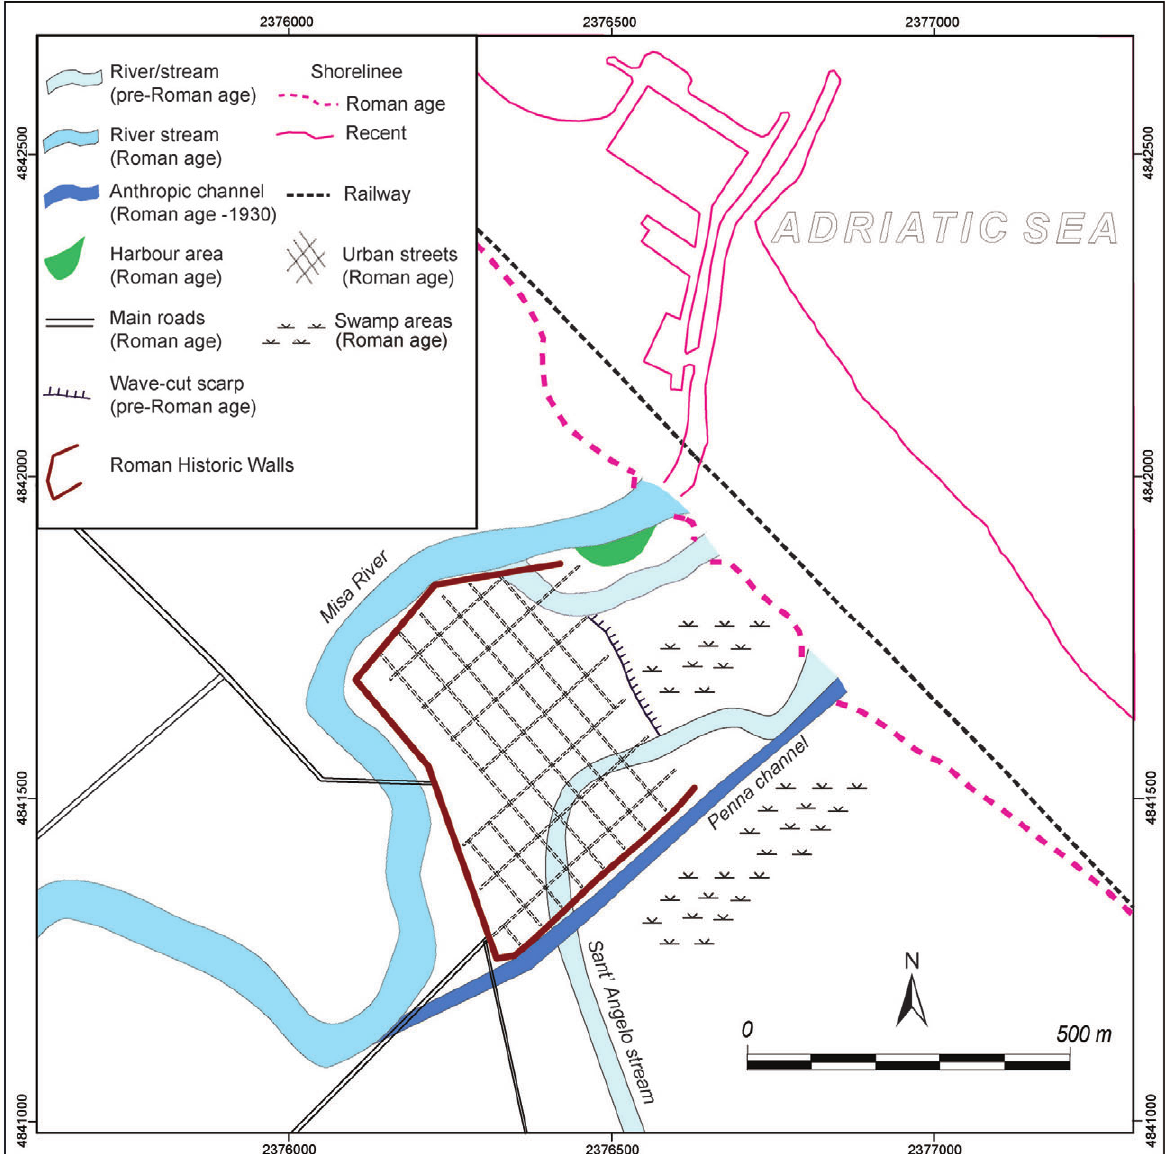
Fig. 6. Morpho-evolutive reconstruction of the Senigallia ( Sena Gallica )